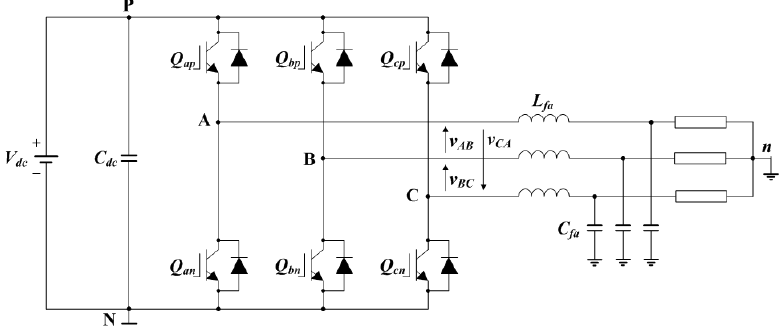
Figure 1. Circuit configuration of three-phase 3-leg inverter.